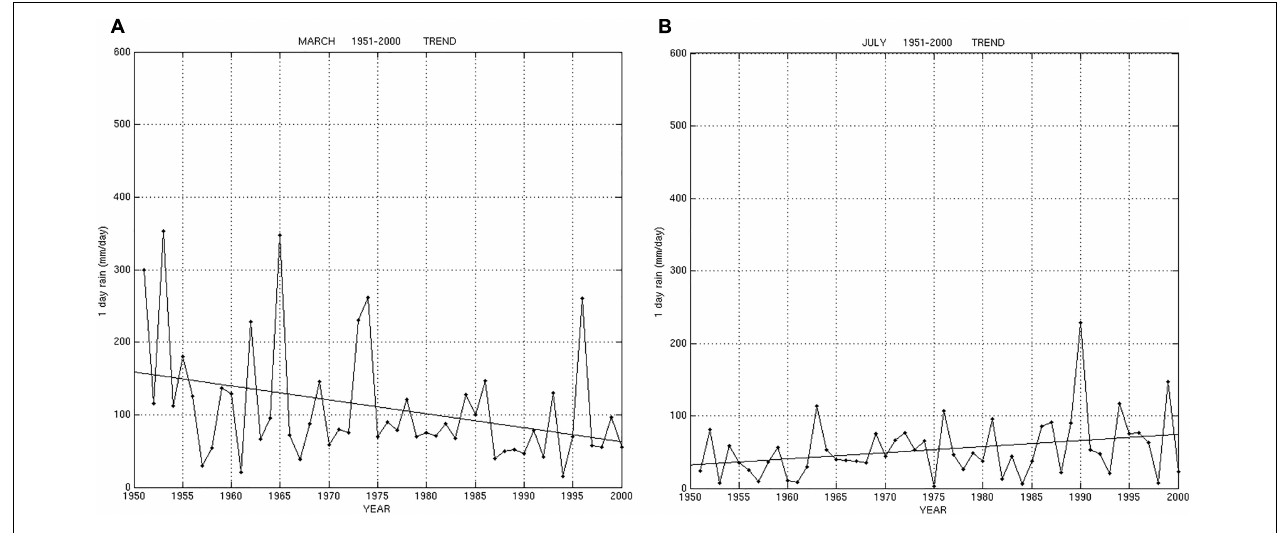
FIGURE 3 | (A,B) March and July series and trend line.